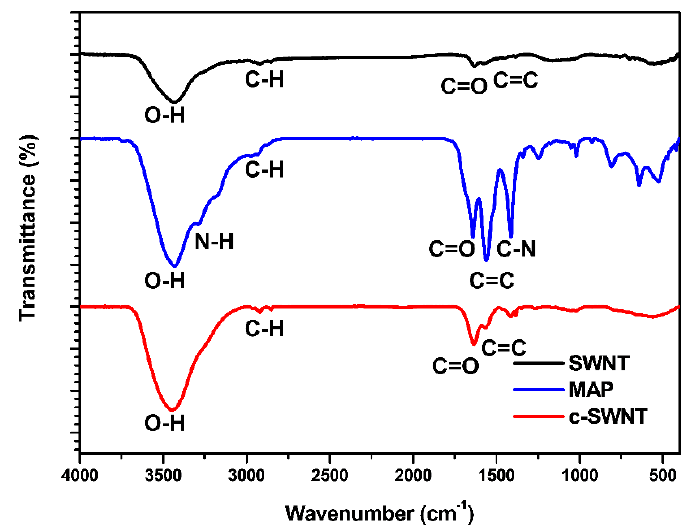
Figure 4. The FT-IR spectra of SWNT, MAP, and c-SWNT .